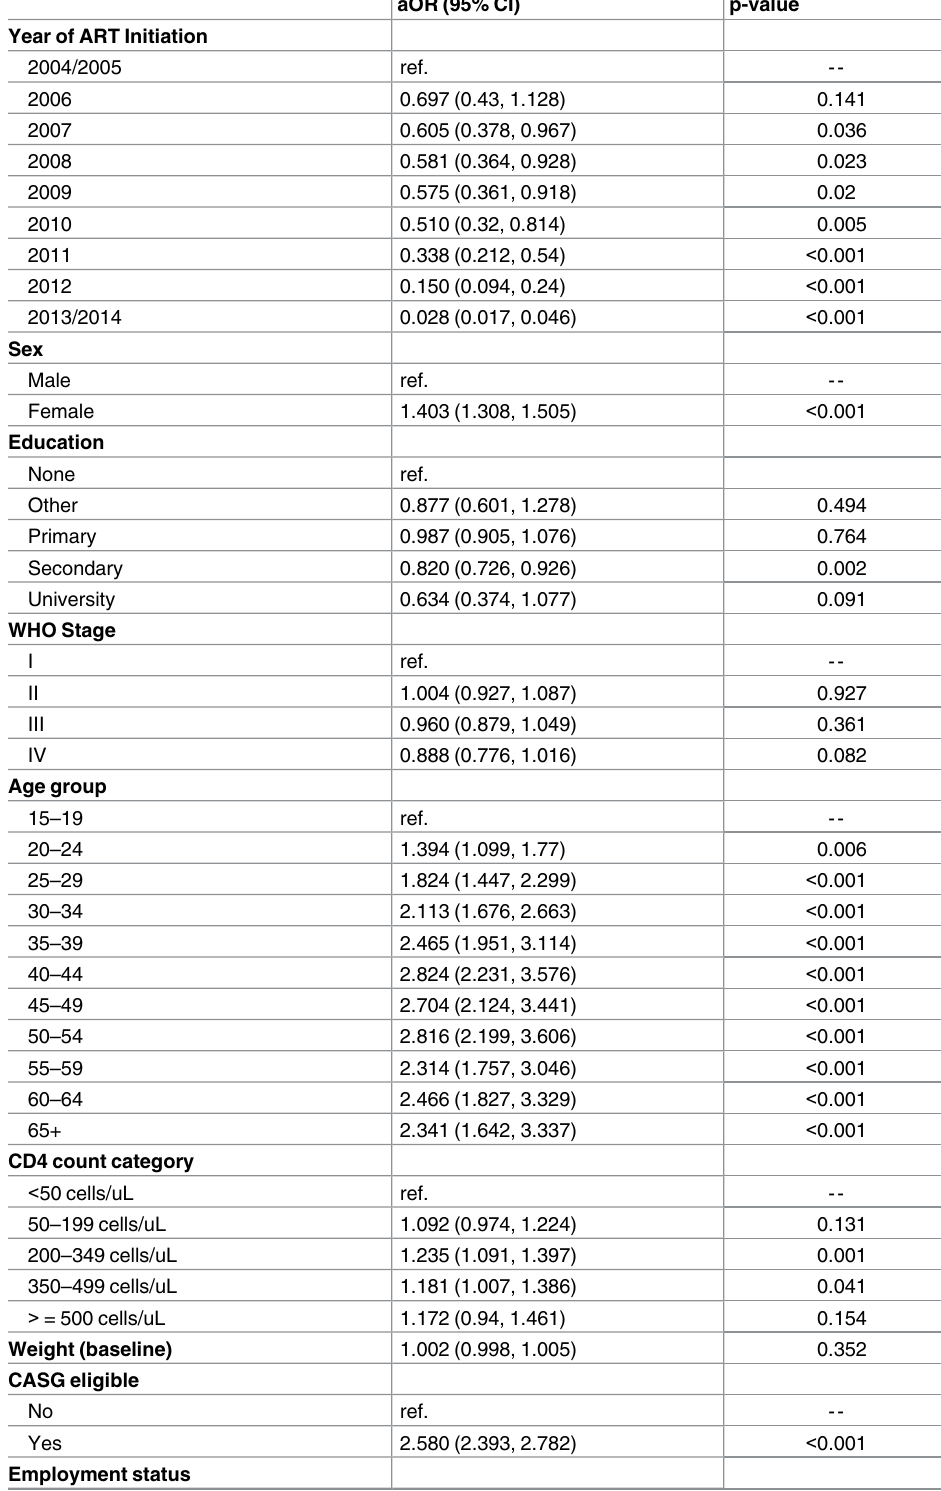
Table 1. Predictors of CASG membership (N = 129,938at 68 facilities providing CASG